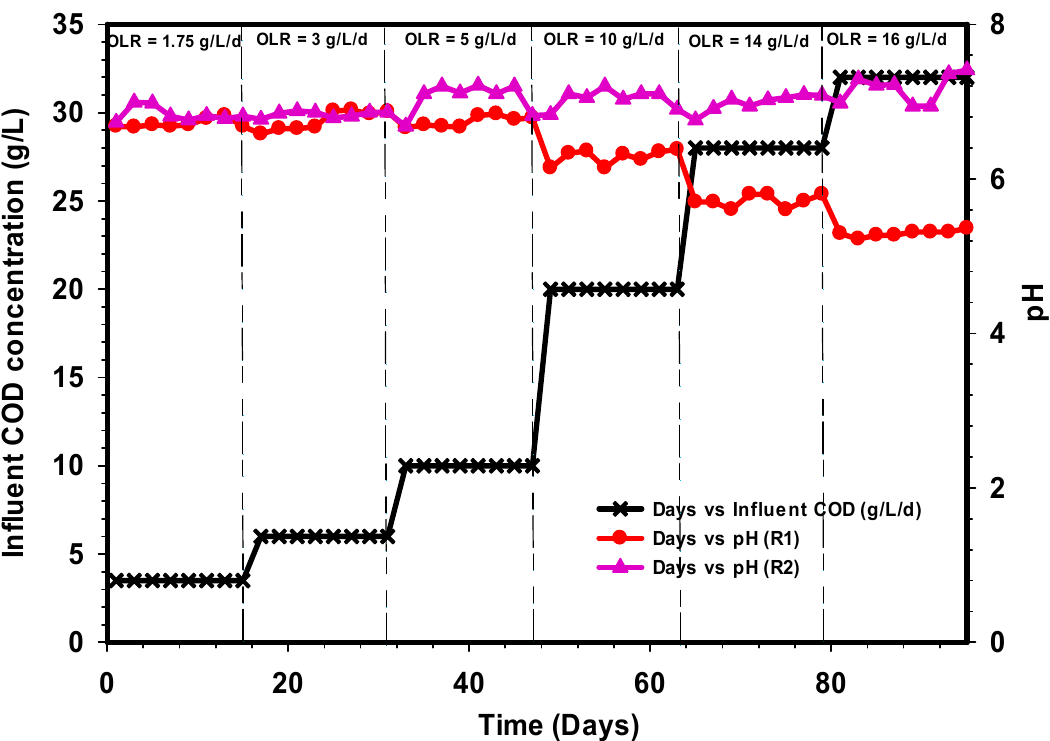
Figure 6. Effect of pH on the on the conventional R1 and the modified R2 UASB reactors. Figure 6. E ff ect of pH on the on the conventional R1 and the modified R2 UASB